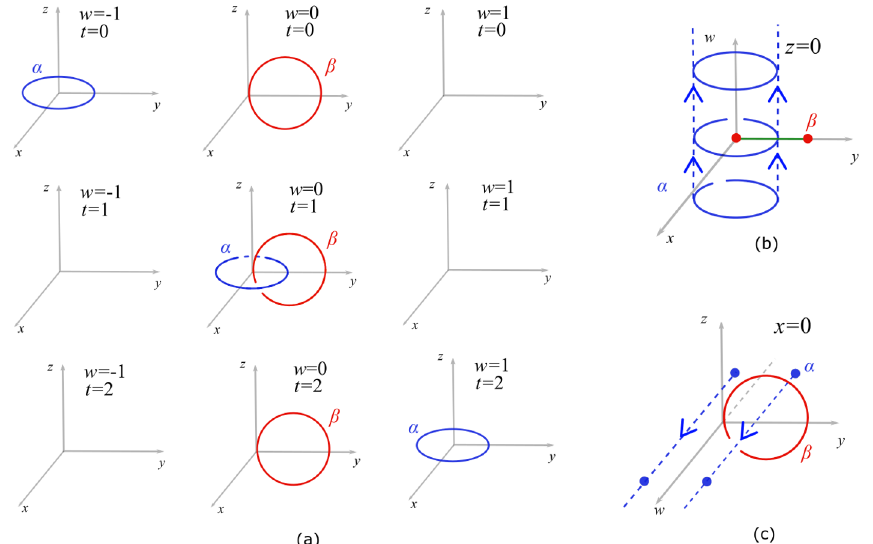
Figure 4 . Diagrammatic representation of loop-loop braiding described by e BdB term. (a) Loop- loop braiding process viewed in xyz -space with different w - and t -coordinates. Loop α (blue) lives on xy -plane with z α = 0 and w α = − 1 at t = 0 . Loop β (red) lives on yz -plane with x β = 0 and w β = 0 . Loop β is assumed to be static in space. When t = 0 , loop α can only be observed in xyz -space with w = − 1 and so does loop β in xyz -space with w = 0 ; as for xyz -space with w = 1 , neither of two loops could be observed. Starting at t = 0 , loop α moves in w -direction such that at t = 1 w α = 0 and loop α and β are linked in xyz -space with w = 0 . Next, loop α continues to move such that w α = 1 at t = 2 . At t = 2 , loop α and β are not linked obviously. Then loop α returns to its initial position in such a way that it would be linked with loop β again. During this process, these two loops never intersect with each other since no points of them share a same 4 D spatial coordinate. (b) Part of the spatial trajectory of loop α (indicated by blue dash lines) observed in xyw -space with z = 0 . In this 3 D space, loop β appears as two points (red solid circles). In 4 D space, e Ω 1 in eq. (2.8) is projected to a 2 D Seifert surface and σ 1 becomes a 2 D closed spatial trajectory. A further projection to xyw -space with z = 0 makes this 2 D Seifert surface appear as a 1 D one (the green segment) whose boundary is two points (red solid circles, exactly the projection of loop β in this 3 D space). This 1 D Seifert surface intersect with loop α ’s spatial trajectory at (cid:12) (cid:17)(cid:12) (cid:16) (cid:12) (cid:12) one point, which implies # = 1 with a sign determined by orientation. (c) Viewed e Ω 1 ∩ σ 1 (cid:12) (cid:12) in wyz -space with x = 0 , loop α appears as two points (blue solid circles) and part of its spatial trajectory is shown as the blue dash lines. This spatial trajectory intersect with loop β ’s 2 D Seifert (cid:12) (cid:17)(cid:12) (cid:16) (cid:12) (cid:12) surface at one point, indicating that # = 1 as e Ω 1 ∩ σ 1 (cid:12) (cid:12)